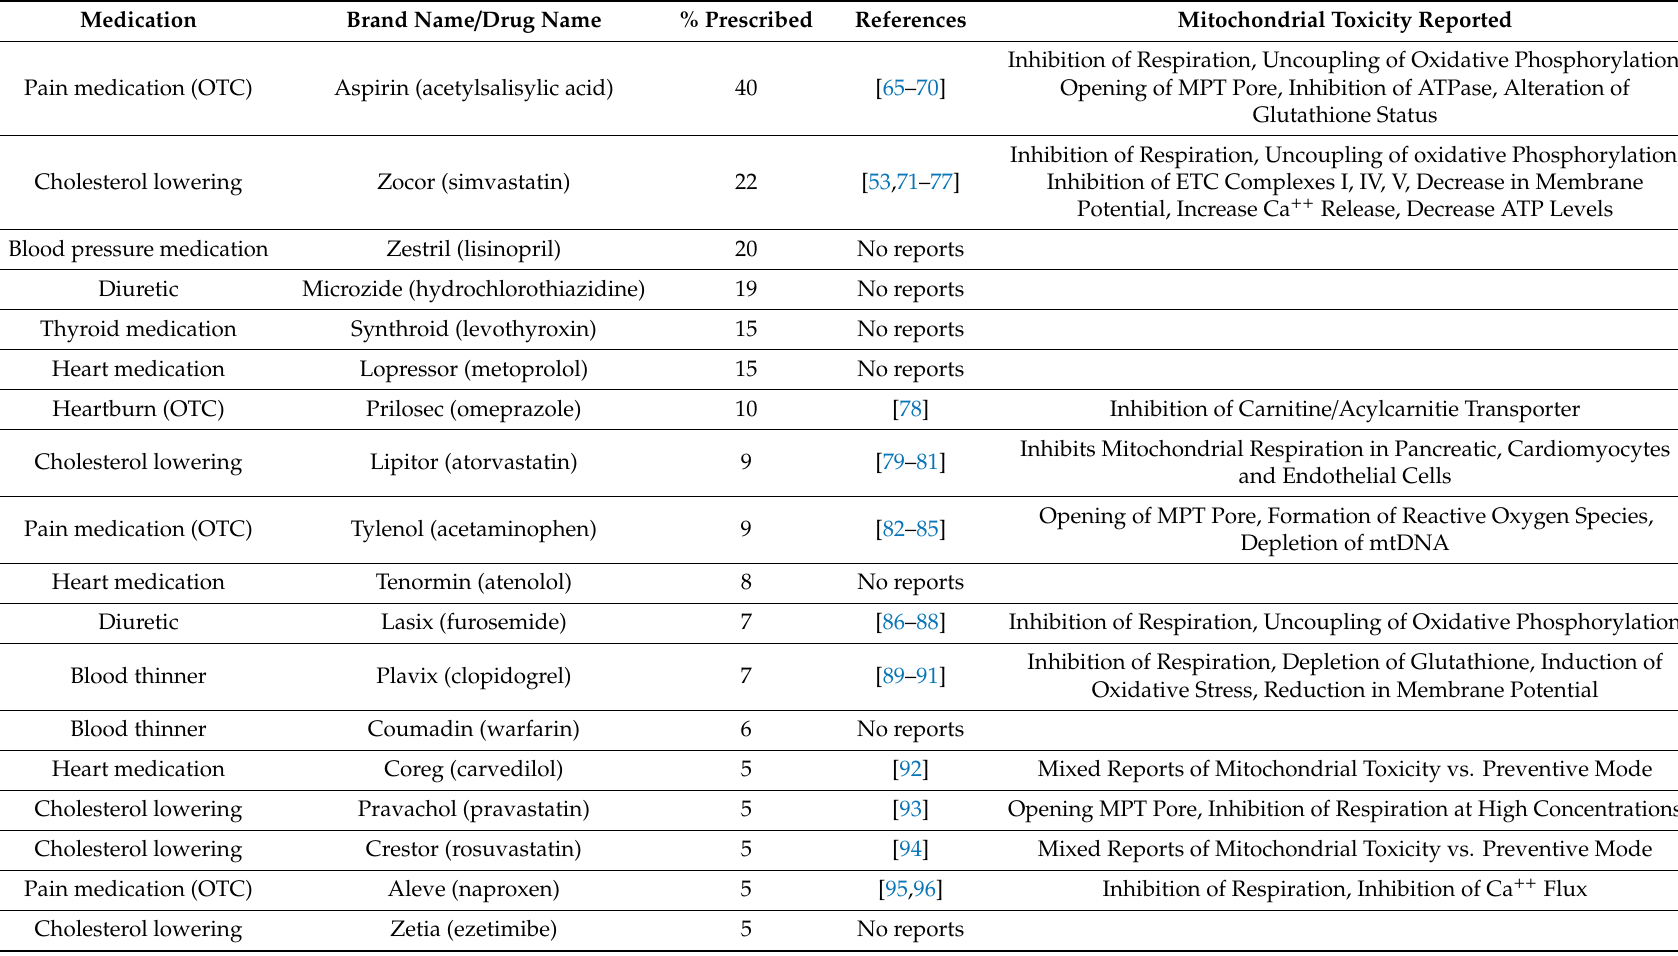
Table 2. Most Commonly Used Prescription and Over-the-Counter Medications (OTC) in US Older Adults. Modified from